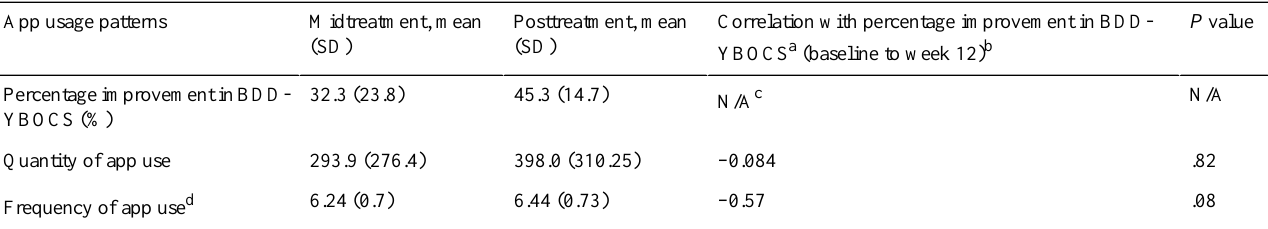
Table 1. Descriptive statistics and correlations between patterns of engagement with smartphone-delivered cognitive behavioral therapy for body dysmorphic disorder and treatment response.